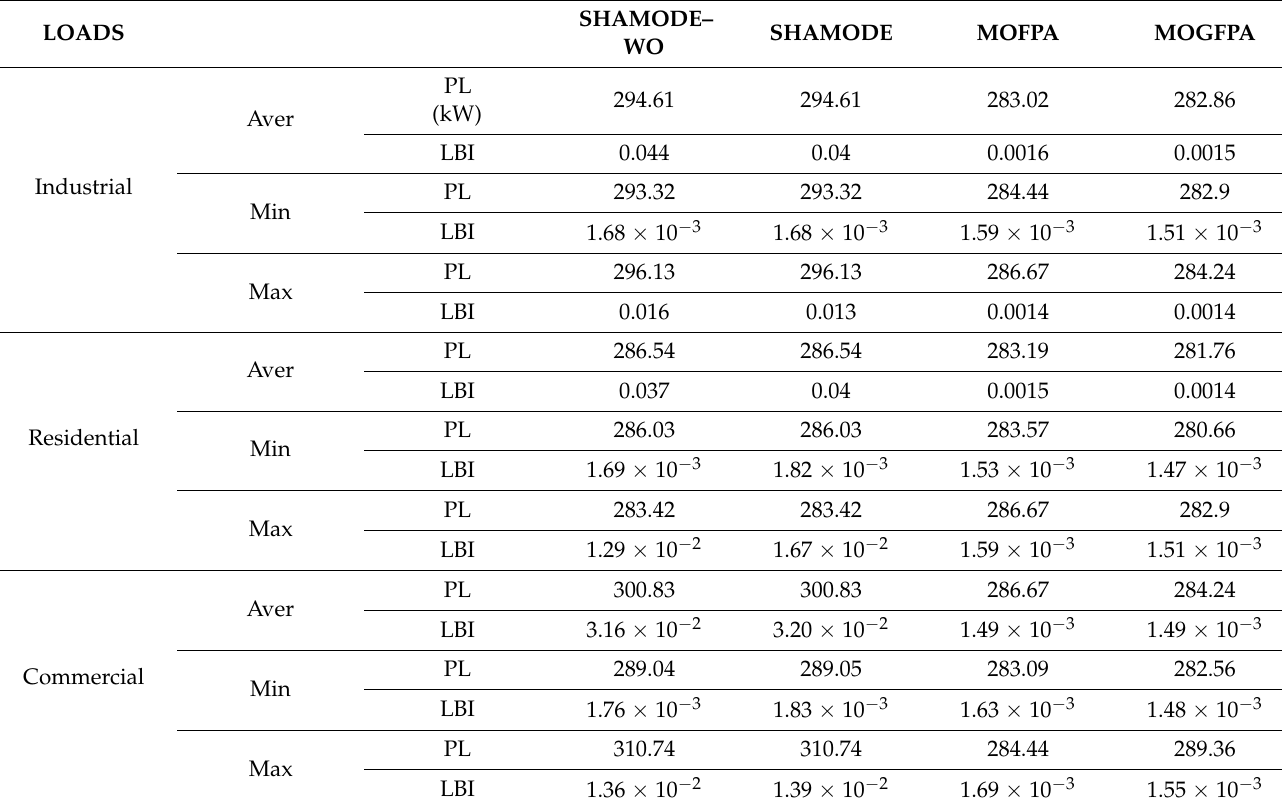
Table 3. PL and LBI comparison under different load conditions for the IEEE 33 bus